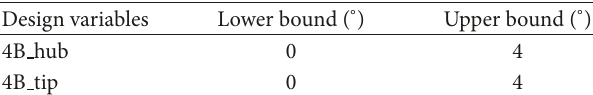
Table 2: Design variables and